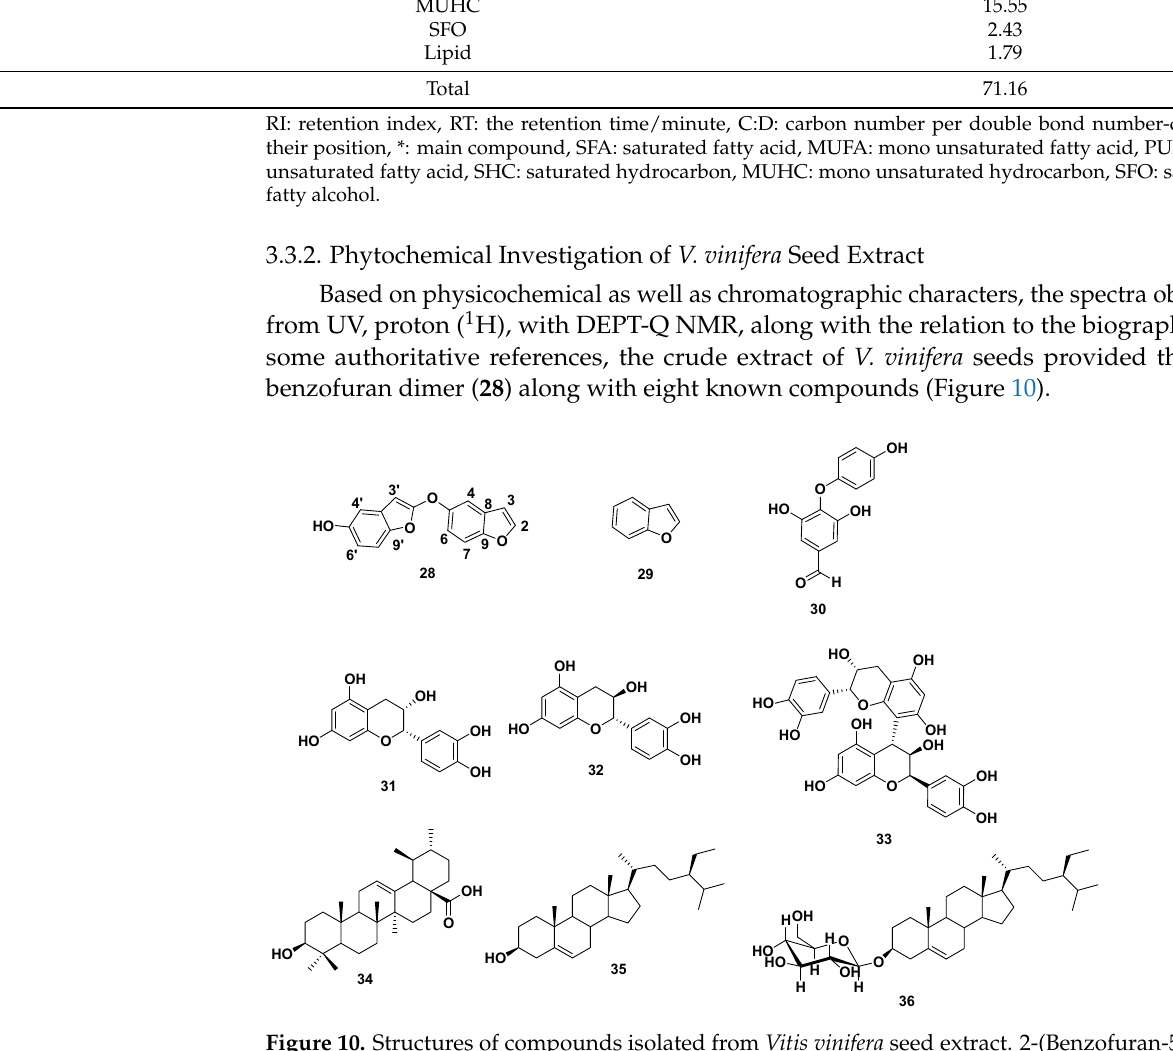
Figure 10. Structures of compounds isolated from Vitis vinifera seed extract. 2-(Benzofuran-5-yloxy) benzofuran-5-ol 28 , benzofuran 29 [20], 4-(4-hydroxyphenoxy)-3,5-dihydroxybenzaldehyde 30 [21]. (-)- Epi -catechin 31 [14], catechin 32 [14], procyanidin B 2 33 [14], ursolic acid 34 [22], β -sitosterol 35 [23], β -sitosterol-3- O -glucopyranoside 36 [24] . Analysis of the [High Resolution Electrospray Ionization Mass Spectrometry], (HR-ESI-MS), 1D, and 2D NMR analysis data of compound 28 advocated a possible dimeric benzofuran derivative core scaffold [25]. The HR-ESI-MS data presented an adduct pseudo-molecular ion peak at m / z 267.0659 [M + H] + (calc. for C 16 H 11 O 4 , 267.0657), suggesting 12 degrees of unsaturation. The 1 H and DEPT-Q 13 C NMR data (Table 2, Figures S2 and S3), as well as HSQC (heteronuclear single quantum correlation experiment) data (Figure S4), predicted nine methine resonance peaks appeared at δ H 7.68, d (7.0) δ C 145.9, δ H 7.09, dd (3.0, 7.0) δ C 104.0, δ H 7.40, d (2.5) δ C 108.8, δ H 6.37, dd (2.5,8.0) δ C 114.0, and δ H 7.30, d (8.0) δ C 123.8, δ H 7.79, d (3.0) δ C 144.5, δ H 7.40, d (2.5) δ C 108.8, δ H 6.37, dd (2.5,8.0) δ C 114.0, δ H 7.30, d (8.0) δ C 123.8, and seven quaternary carbons at δ C 113.5, 116.8, 148.4, 148.4, 157.3, 157.3, and 160.8, indicating the characteristic core structure for dimeric benzofuran derivatives [25], where HMBC (heteronuclear multiple bond correlation) experiment of 28 (Figures 11 and S5) confirmed that. The downfield shift for resonating peaks for C5, C5` at 148.4, and 160.8, suggested the presence of hydroxyl groups at C5 and C5` in each benzofuran unit. Table 2. DEPT-Q (400 MHz) and 1 H-NMR (100 MHz) data of compound 28 in CDCL 3 ; carbon mul- tiplicities were figured out by the DEPT-Q experiments. Position